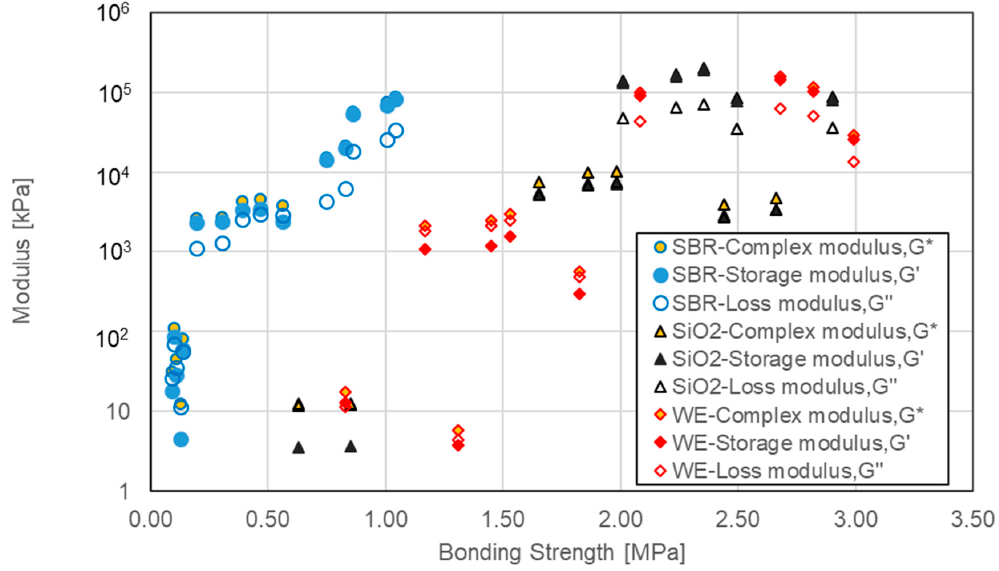
Figure 19. Relation between bonding strength and various modulus parameters.